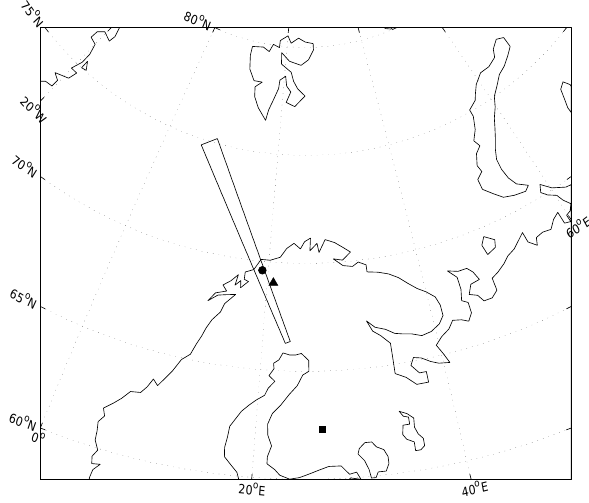
Fig. 2. The locations of the instruments used. The square indicates the CUTLASS Hankasalmi radar and the circle the EISCAT Tromsø site. The triangle marks the imaging riometer at Kilpisj¨arvi. Also shown is the field-of-view of beam 5 of the Hankasalmi radar used in the